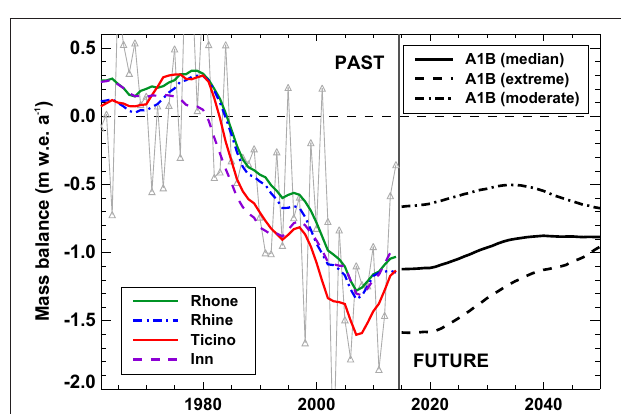
FIGURE 9 | Average annual mass balance 1961–2014 for all very small glaciers in Switzerland (gray). Eleven-year running means for the subsets of the four large-scale catchment are shown. Future mass balances refer to the A1B scenario and the respective uncertainty ranges (extreme/moderate